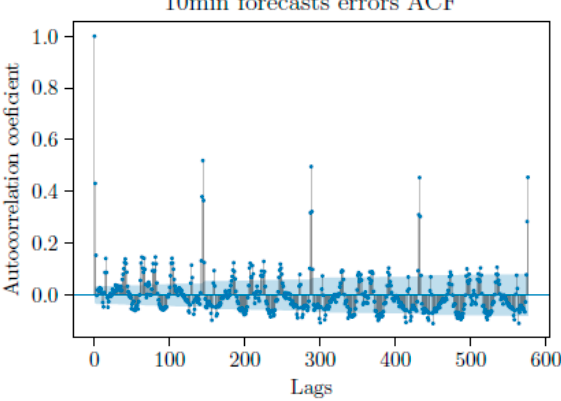
Figure 14. Ten-minutes-ahead error autocorrelation.